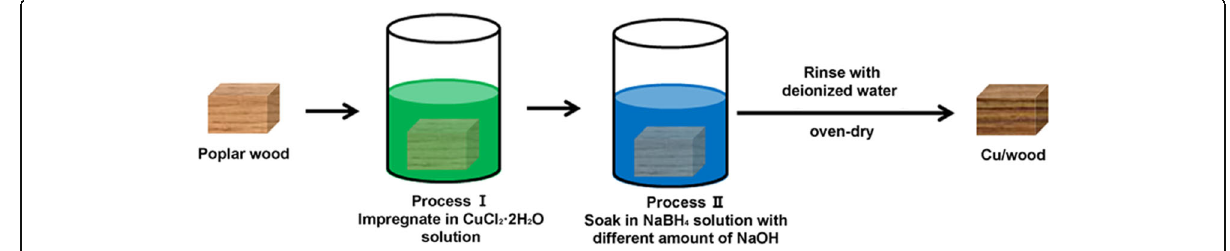
Fig. 2 Fabrication process of hybrid wood